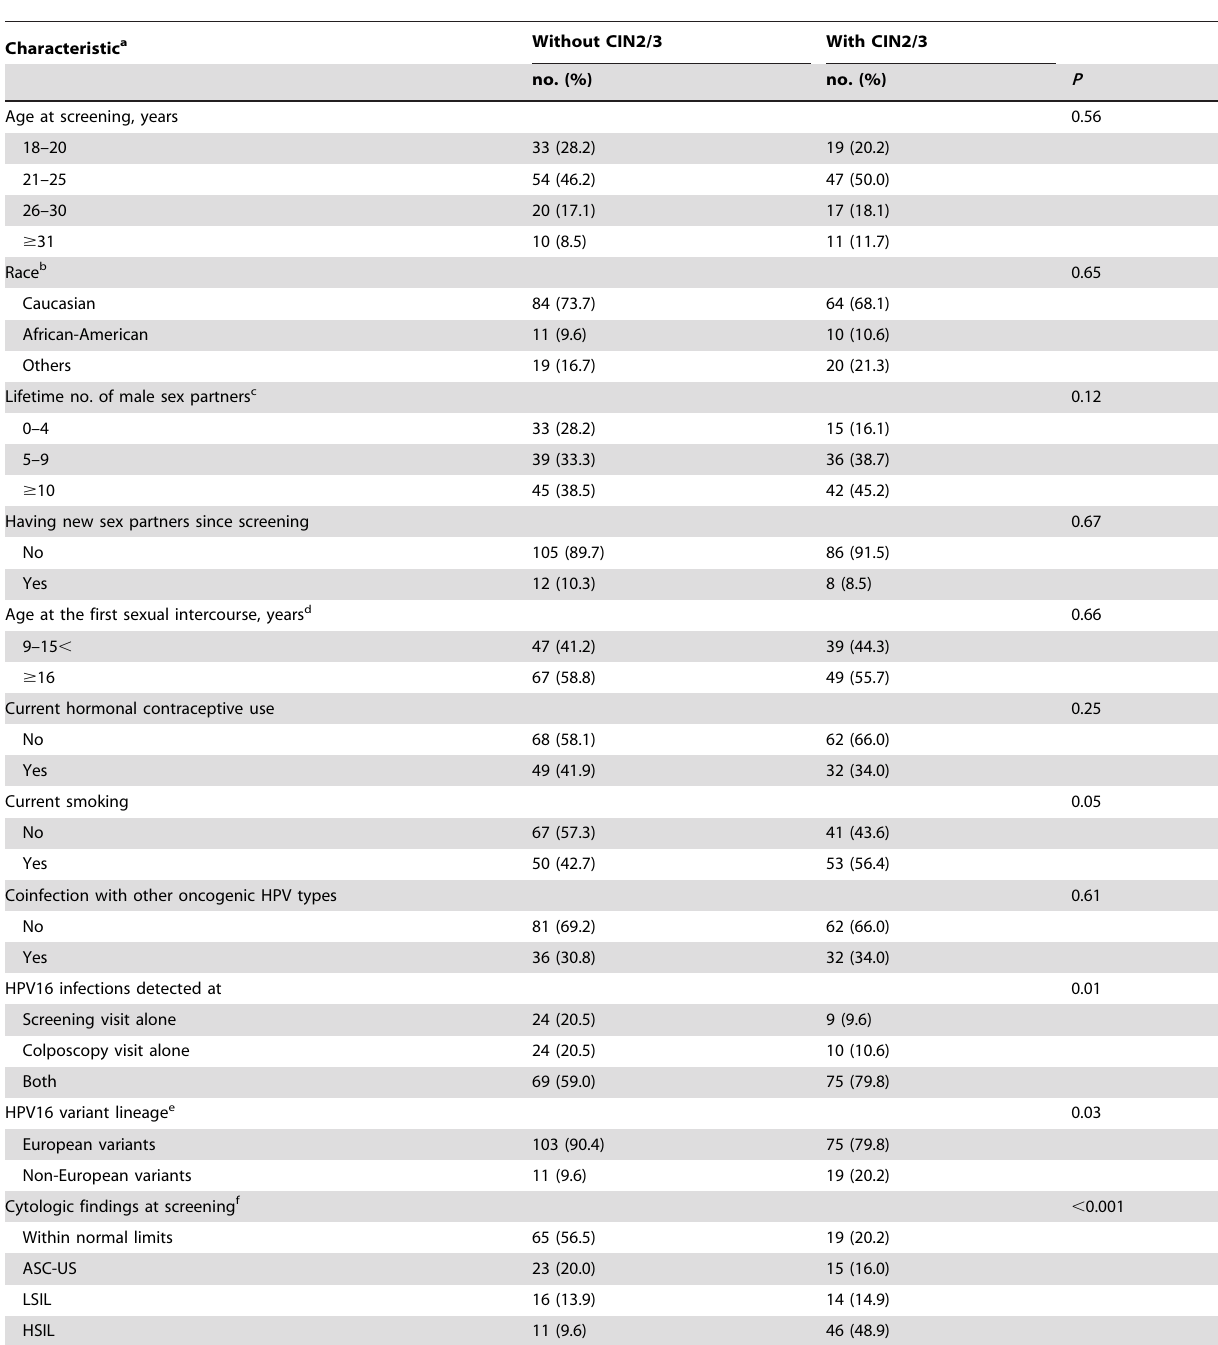
Table 1. Characteristics of HPV16-positive women with and without